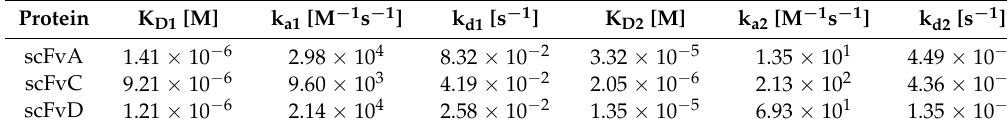
Table 1. Kinetic constants of the generated anti-FGF1 scFvs.